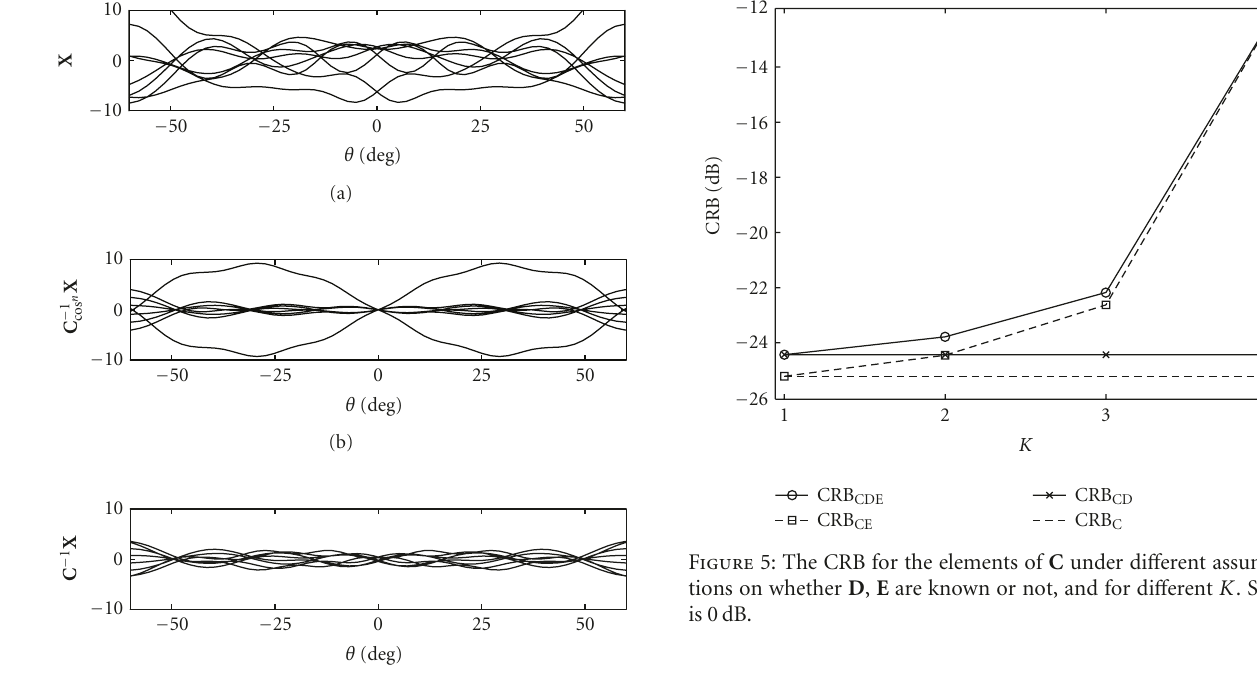
(cid:22) α k Q k , respectively. The true